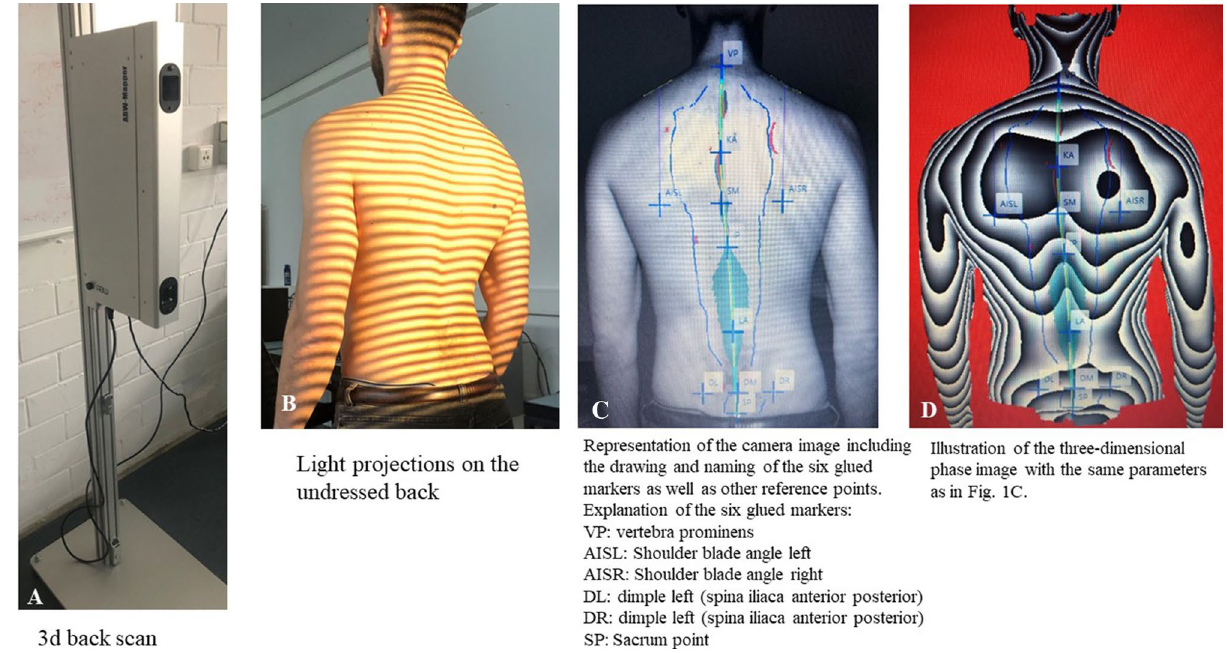
Figure 1. Marking of the six anatomical fixed points. These points comprised the vertebra prominens (cervical vertebra C7), the right and left angulus inferior scapulae, the right and left spina iliaca posterior superior and the most cranial point of the rima